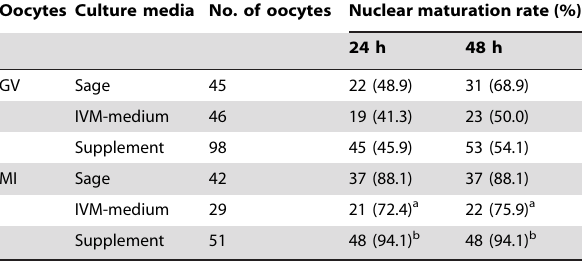
Table 1. Nuclear maturation of cumulus-free human oocytes in vitro from hormone-stimulated